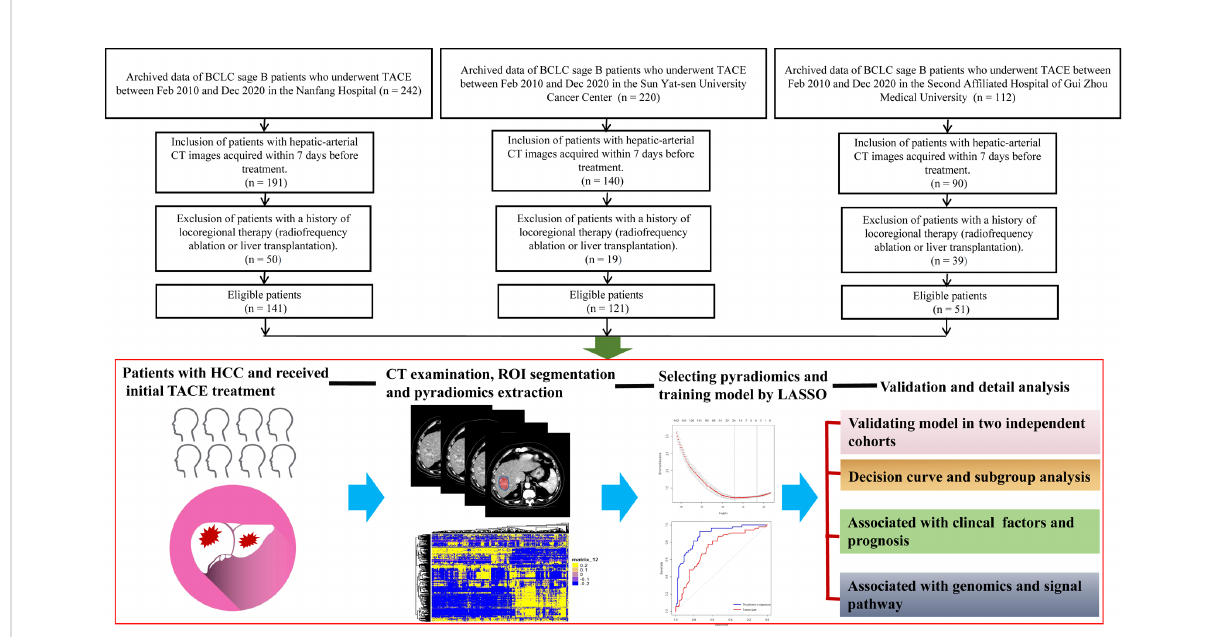
FIGURE 1 Flowchart for the development of the machine learning model. All patients have radiologically or pathologically proven HCC and undergo CT before TACE therapy. The radiologists manually segment the 3D ROIs. Thereafter, 1,167 features are extracted from the hepatic arterial CT images based on the “ pyradiomics ” package of python. Using LASSO method, 24 features are selected, and the pyradiomics model is built. Model validity is evaluated in two cohorts. The predictive performance of the pyradiomics model is compared with that of clinical factors. The association between the pyradiomics model and cancer signaling pathways is analyzed using the TCGA-HCC cohort. 3D, three-dimensional; HCC, hepatocellular carcinoma; CT, computed tomography; ROI, region of interest; LASSO, least absolute shrinkage and selection operator algorithm; TCGA, The Cancer Genome